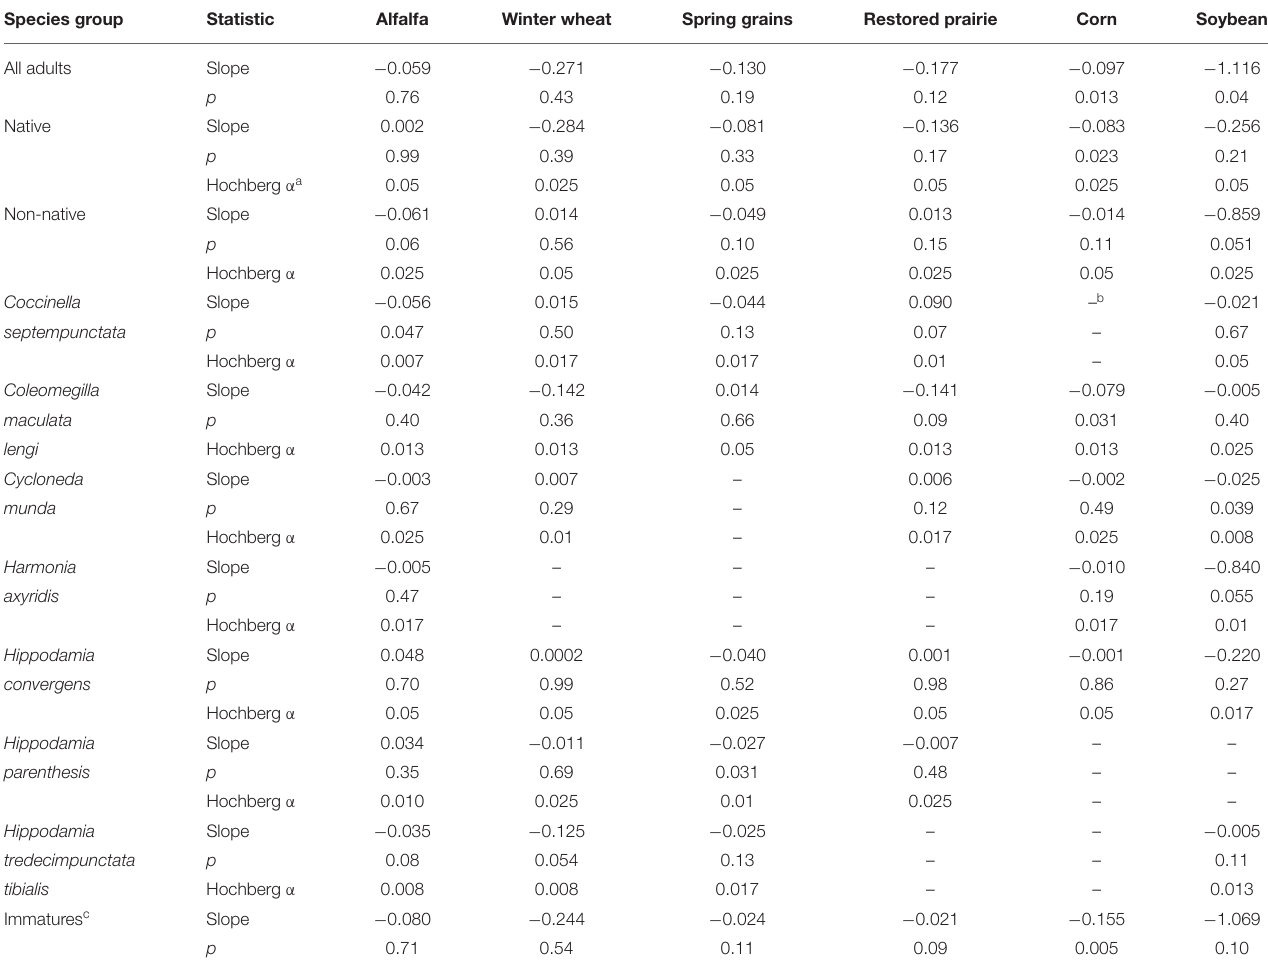
TABLE 3 | Slopes of linear regressions of annual abundance of adult coccinellids by species groups across years of sampling in six habitats. Species